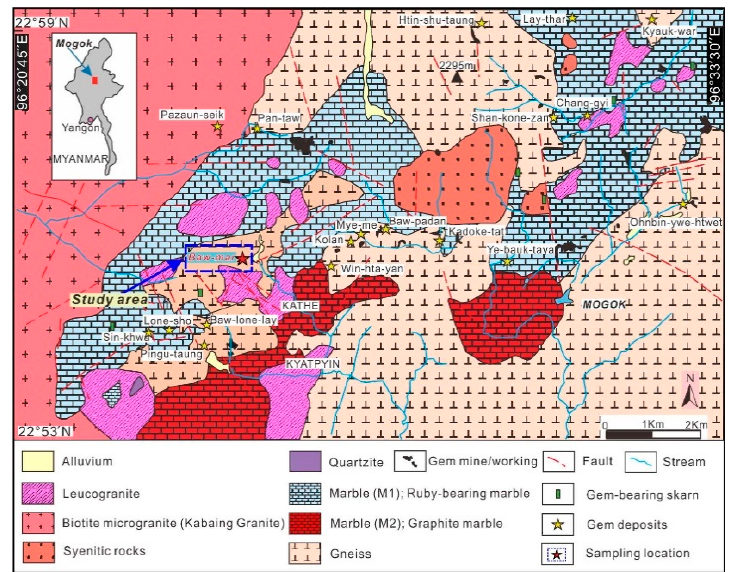
Figure 1. Regional geological map showing general distribution of the ruby/sapphire mine/workings and geological settings of the Mogok gemfield, Myanmar. The sampling location is shown by blue box (modified after [8]).